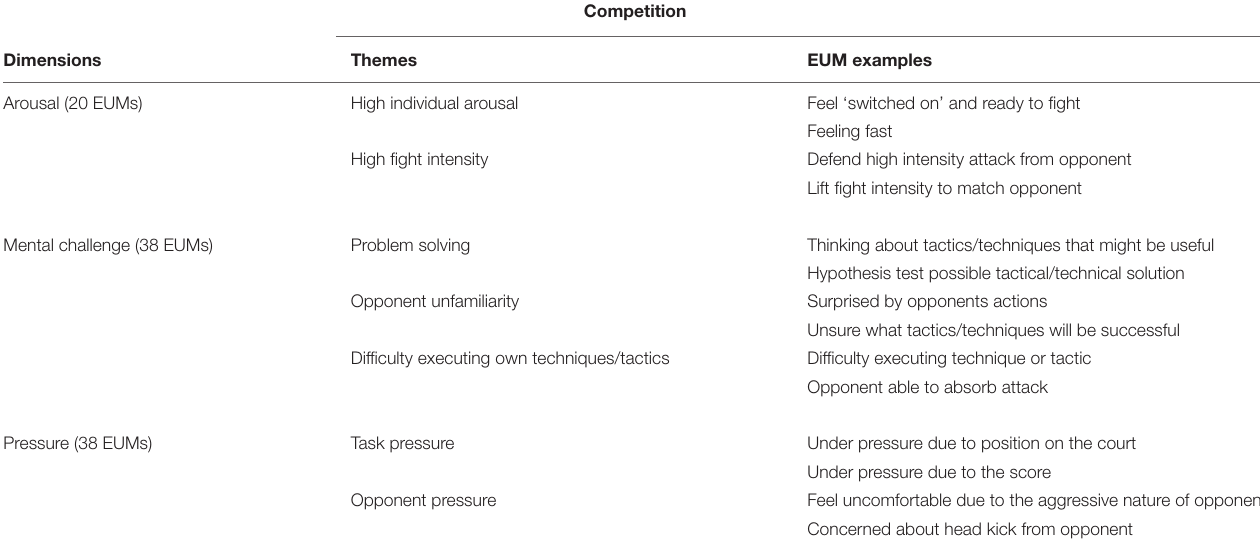
TABLE 4 | Synthesized interview data from the competition condition relating to affective-cognitive differences between environments.